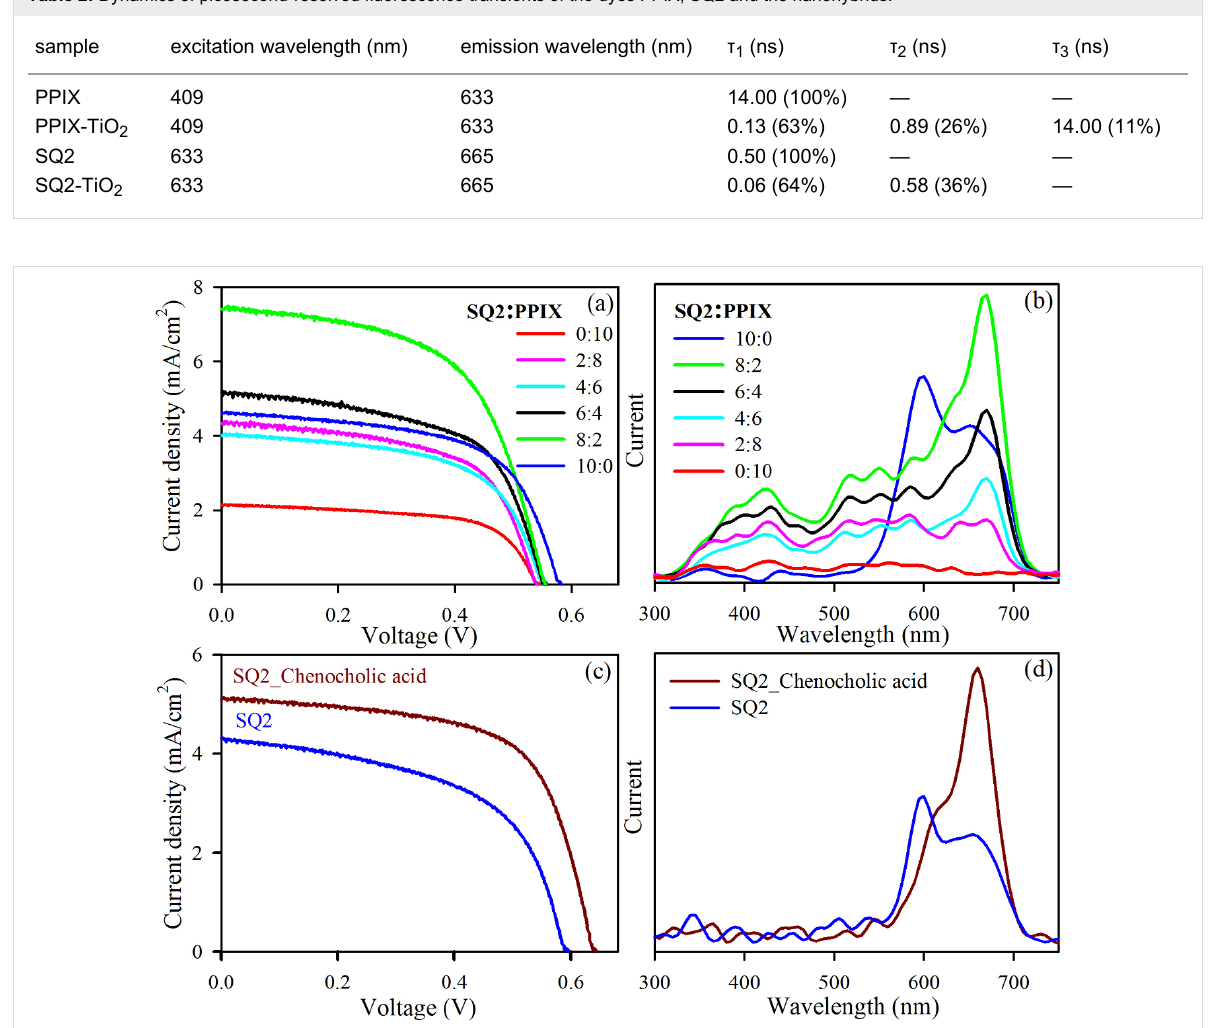
Figure 5: (a) I – V characteristics and (b) wavelength-dependent photocurrent of DSSCs sensitized with different ratios of SQ2 and PPIX. (c) I – V char- acteristics and (d) wavelength-dependent photocurrent for SQ2 and a mixture of SQ2 and 5 mM chenodeoxycholic acid.